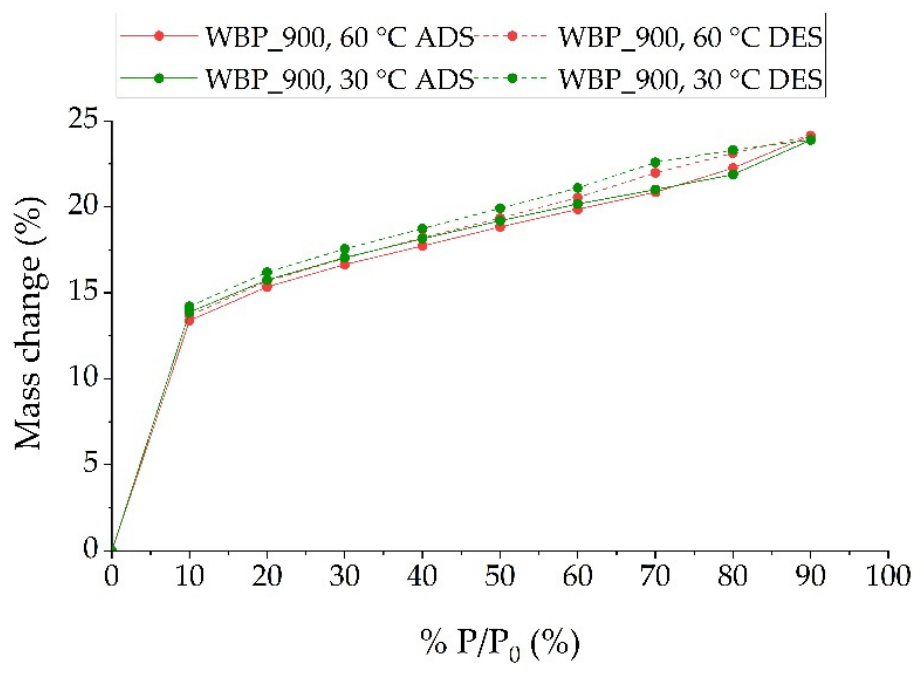
Figure 9. Adsorption and desorption isotherms for the sample WBP_900 at 30 and 60 °C.